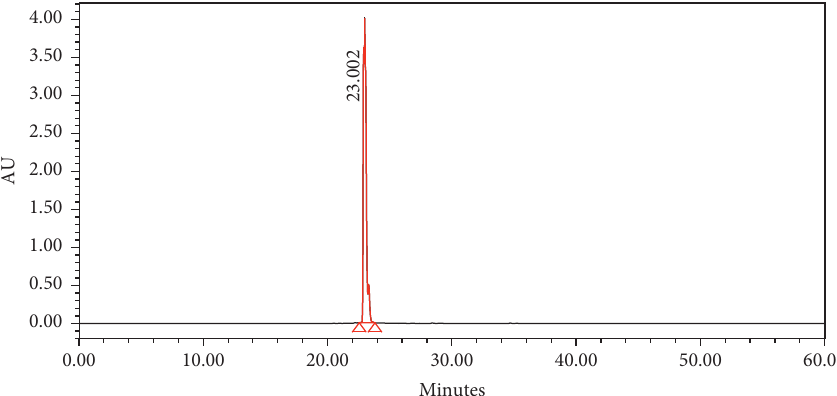
Figure 5: Normal-phase HPLC profile of isovitexin (standard) identified at a retention time of 23.002min.